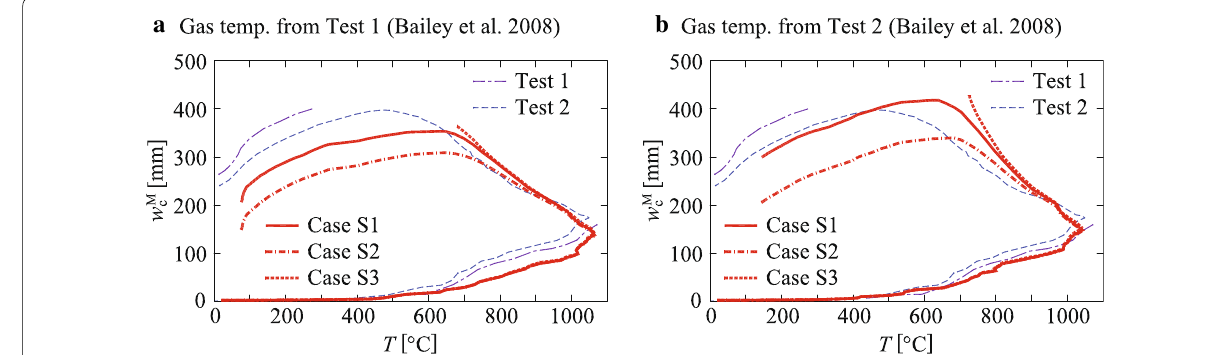
Fig. 10 Development of computed and measured vertical midspan displacements as a function of fire compartment temperature: a gas temperatures from Test 1 and b from Test 2.